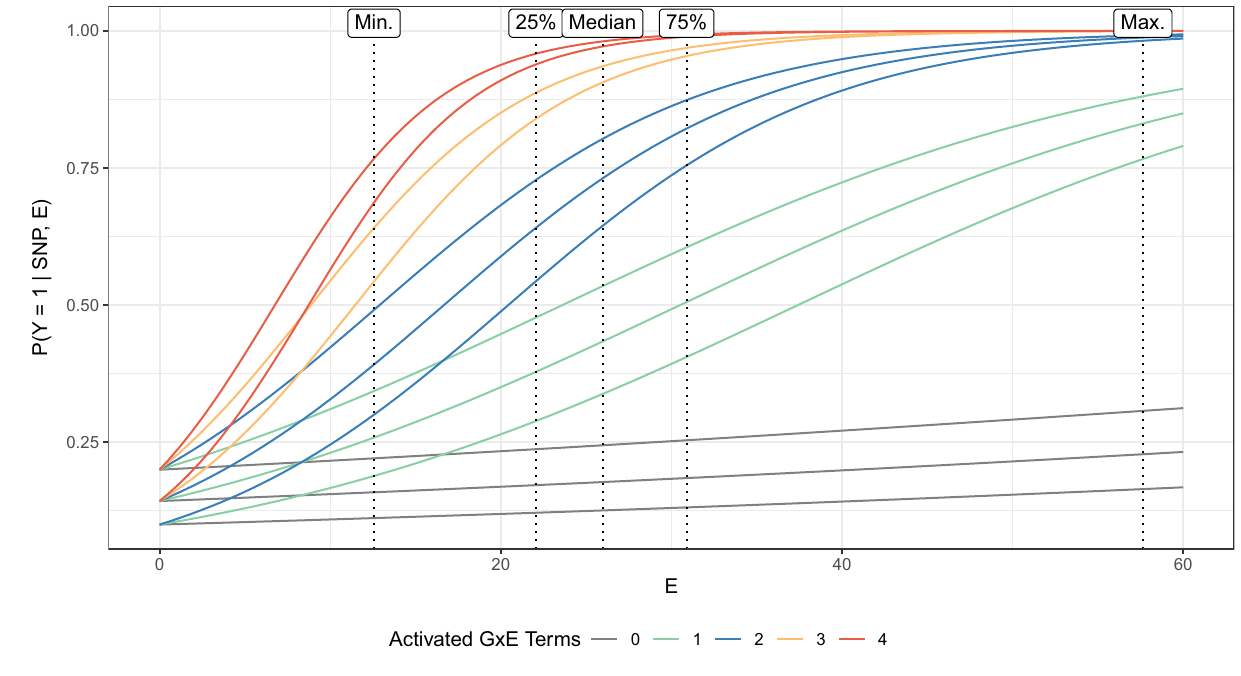
Figure 2. Design for simulating a binary phenotype. Exposure-response curves are depicted for different genotypes and a strong GxE interaction effect α GxE = log ( 1.05 ) in Eq. (4). The colors illustrate the GxE interaction intensity referring to the number of activated GxE interaction terms in Eq. (4). The utilized distribution of the environmental factor is shown at the top by the 25%, 50%, and 75% quantiles and the minimum and the